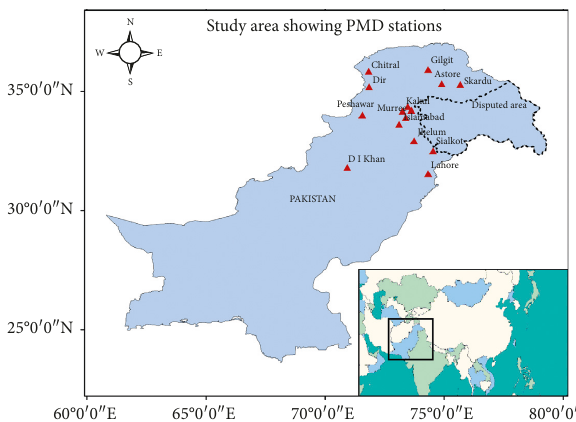
Figure 1: Map of study area showing the location of PMD’s meteorological stations (red triangles) constituting the monsoon belt in